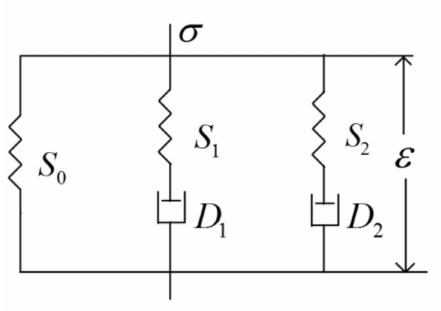
Figure 2. Rheological model for binder and conductive composite (BCC) composed of two Maxwell elements and a spring in parallel.